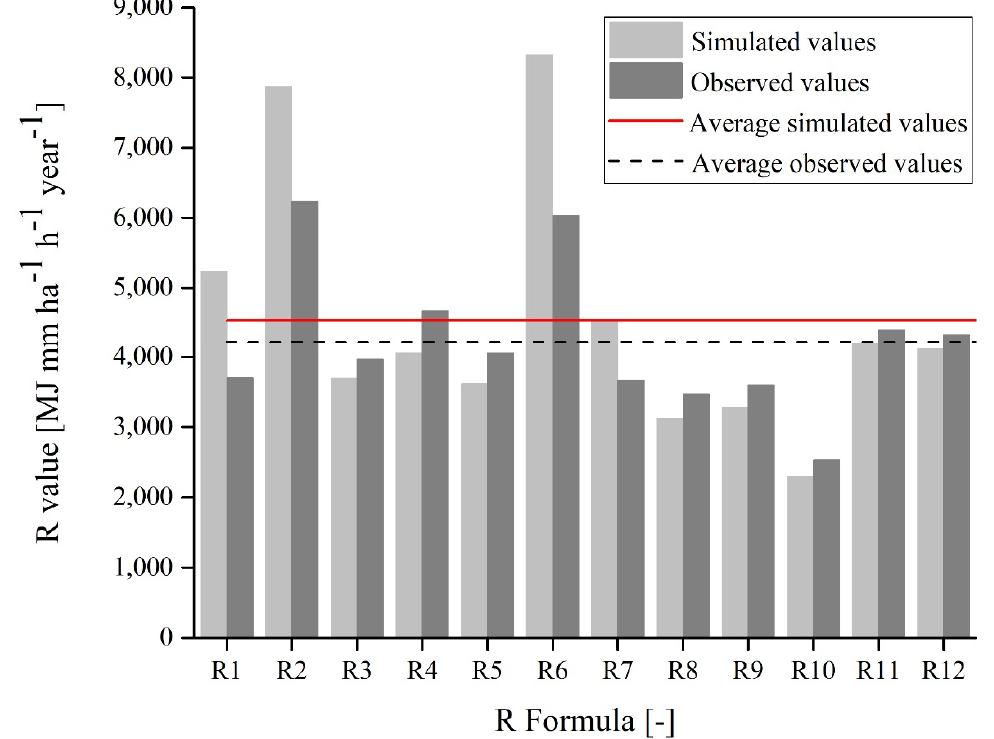
Figure 8. Rainfall erosivity value obtained with the 12 investigated equations, respectively, with simulated and observed rainfall data set. The red line represents the average of 12 values obtained considering the synthetically generated rainfall data, while the black dashed line represents the average of 12 values obtained considering the observed data.